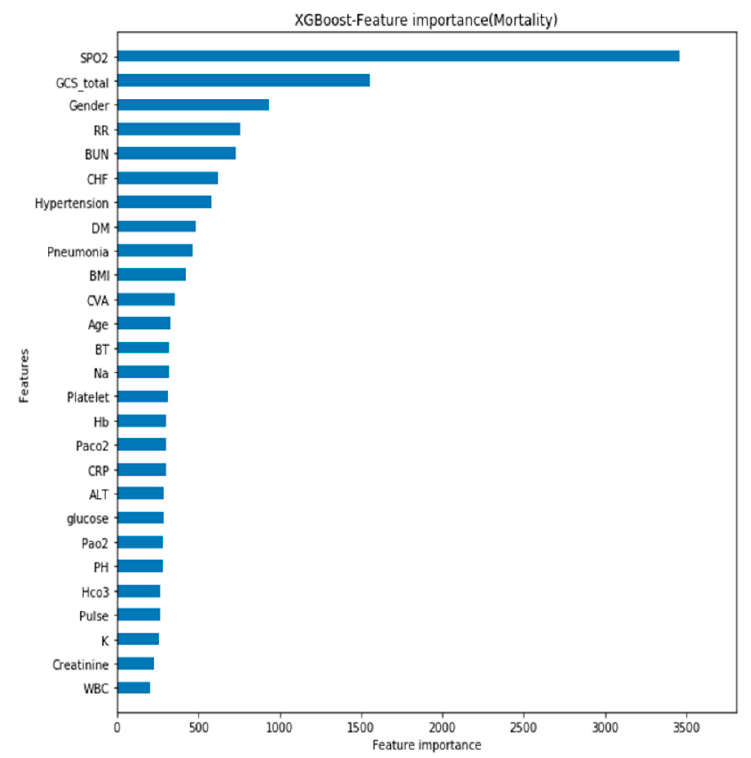
Figure 5. ROC of ventilator dependence in patients with COPD.